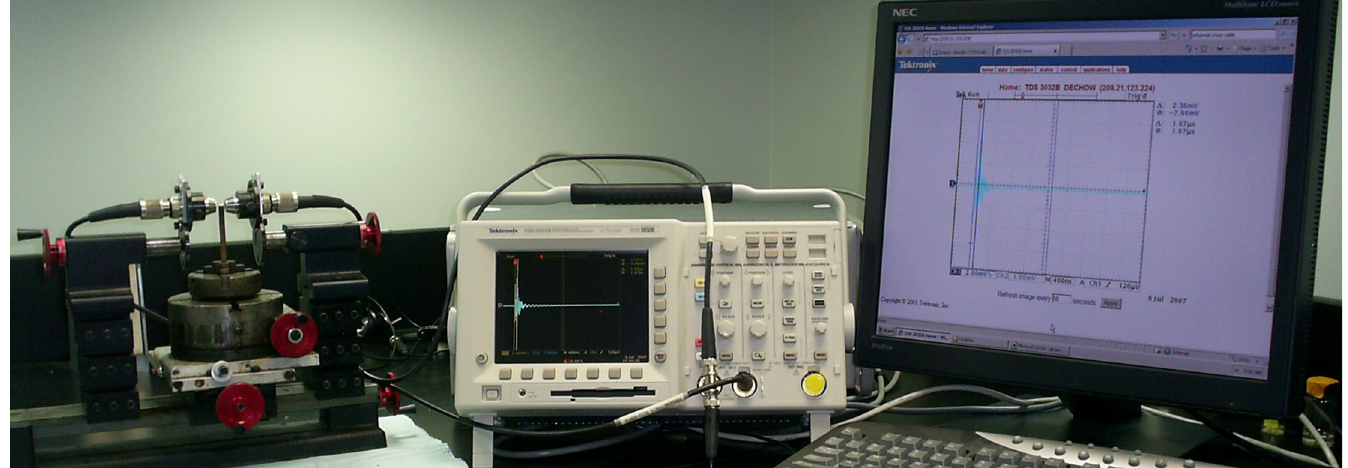
Fig 2. Ultrasonic system used to test mechanical properties in cylindrical cortical bone